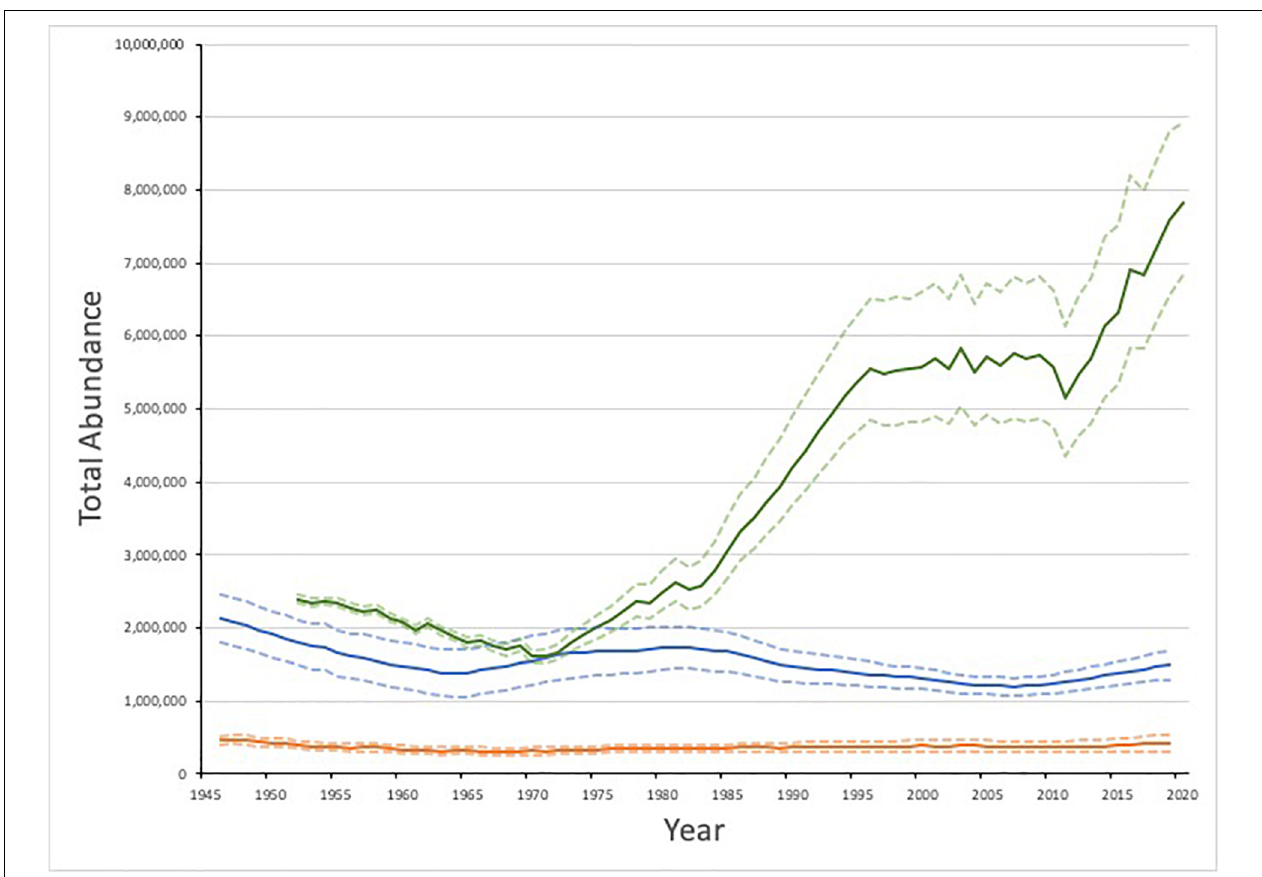
FIGURE 3 | Estimated abundance of Greenland Sea (orange), White Sea/Barents Sea (blue) and Northwest Atlantic (green) harp seals and 95% C.I. Data from International Council for the Exploration of the Sea [ICES], 2019b and Hammill et al., 2020.